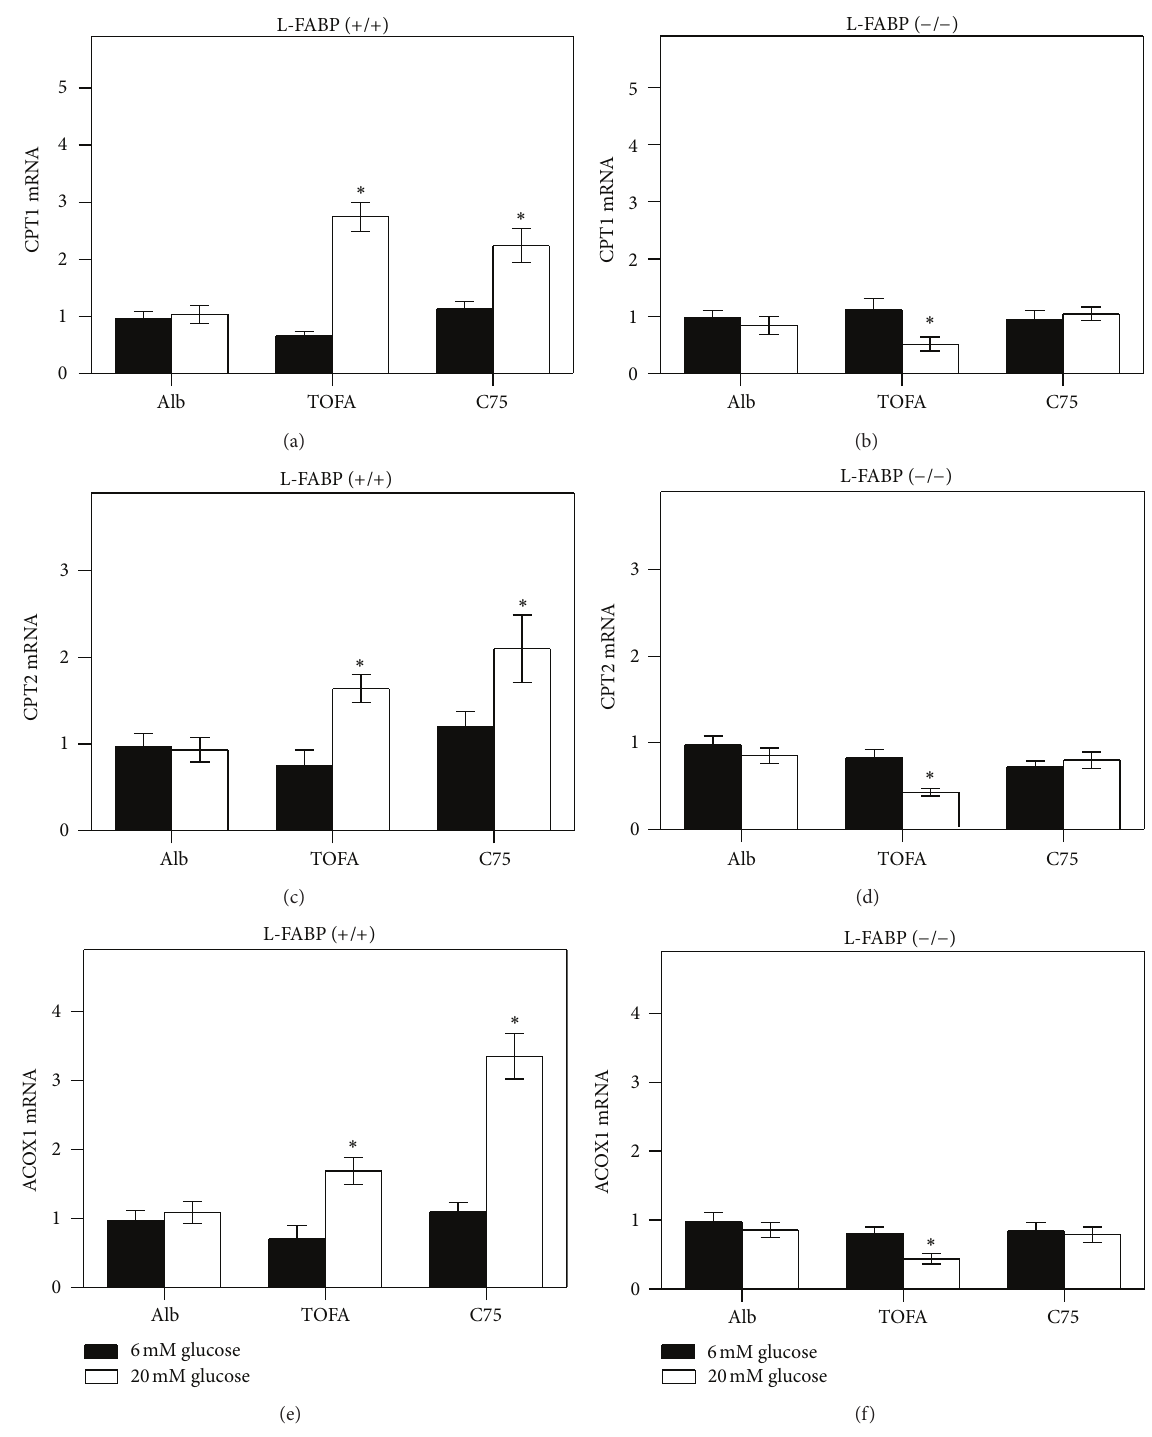
Figure 12: Effect of TOFA and C75 on CPT1, CPT2, and ACOX1 gene expression in cultured mouse primary hepatocytes isolated from livers of wild-type (WT, L-FABP (+/+)) and null [(L-FABP (−/−) ] mice. Hepatocytes isolated from wild-type [WT, L-FABP (+/+)] or gene-ablated [null,L-FABP (−/−) ]micewerepreincubatedfor30 minwith10 𝜇 g/mLTOFAorC75inserum-freeculturemediumbeforeadditionofglucose (6 or 20mM) as described in Methods. Total RNA was isolated from hepatocytes 5hr after glucose addition and used for quantitative real- time PCR. The fold change in CPT1A (a, b), CPT2 (c, d), ACOX1 (e, f) mRNA levels was determined relative to internal control housekeeping gene as described in Methods. Values for each genotype were expressed relative to [Alb + 6mM glucose] within that genotype. Panels (a), (b): CPT1A mRNA fold changes in WT and L-FABP null hepatocytes; (c), (d): CPT2 mRNA fold changes in WT and L-FABP null hepatocytes; (e), (f): ACOX1 mRNA fold changes in WT and L-FABP null hepatocytes. Mean ± SEM, 𝑛 = 3